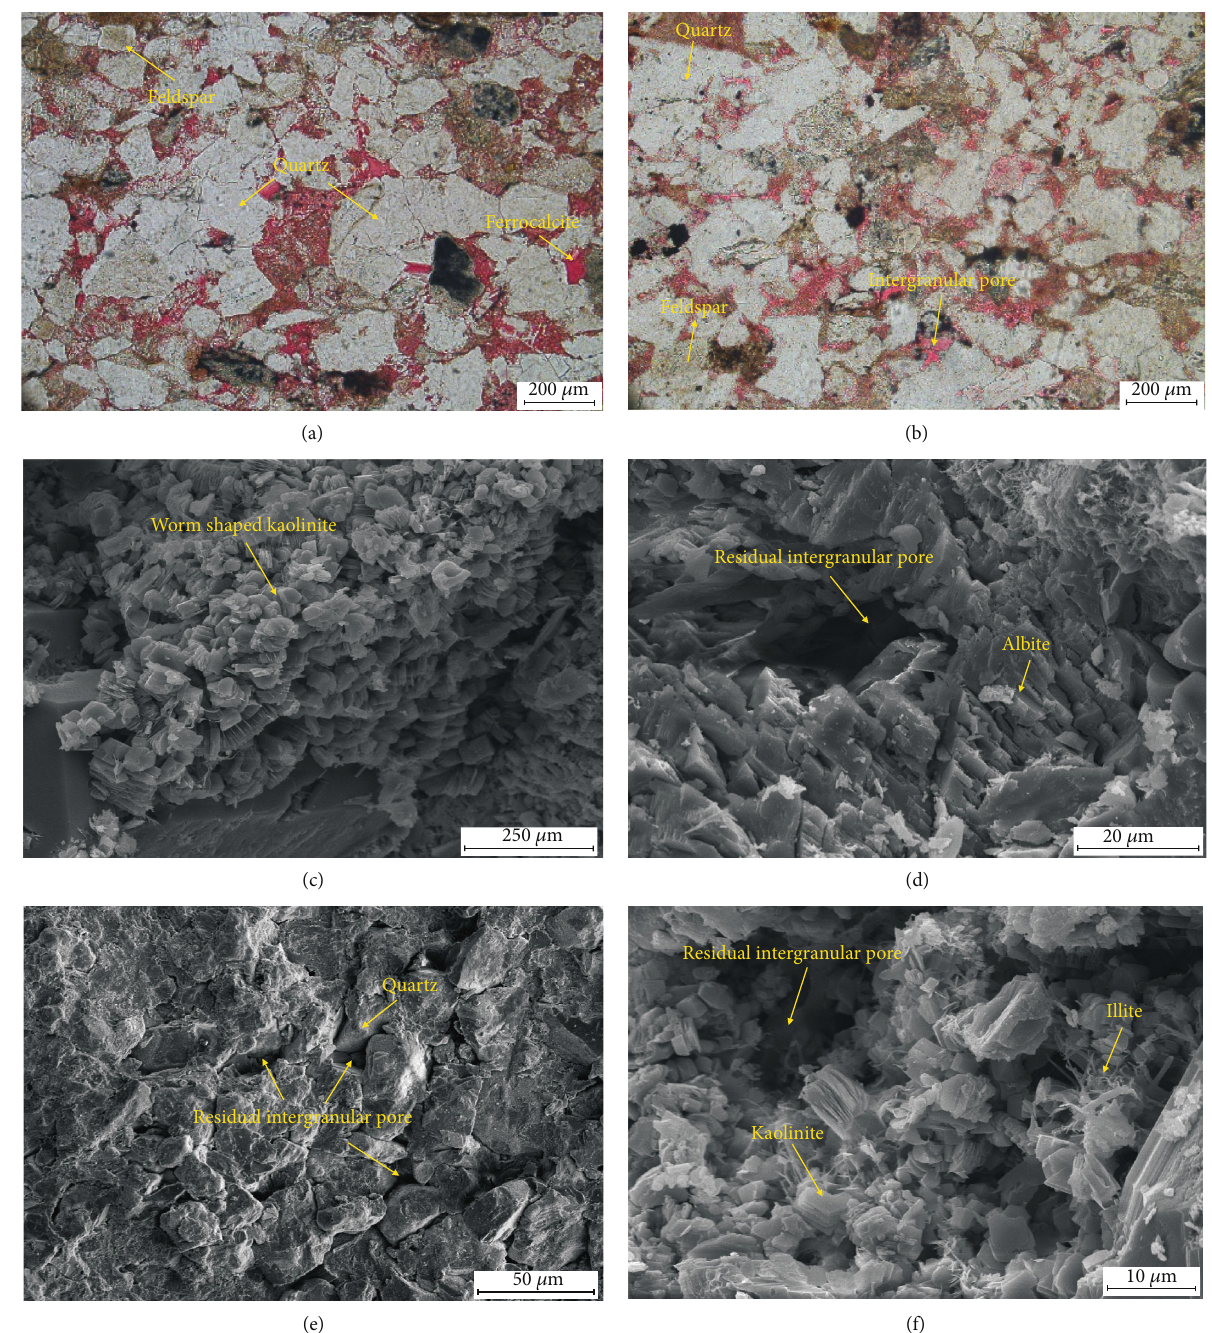
Figure 4: Cast body thin section and SEM image in the sandstone of the Yan 9 32 layer. (a) Feldspar, quartz, and iron calcite. (b) Quartz, feldspar, and intergranular pore. (c) Vermicular kaolinite. (d) The remaining intergranular pores and albite. (e) Quartz and residual intergranular pores. (f) Residual intergranular pores, illite, and